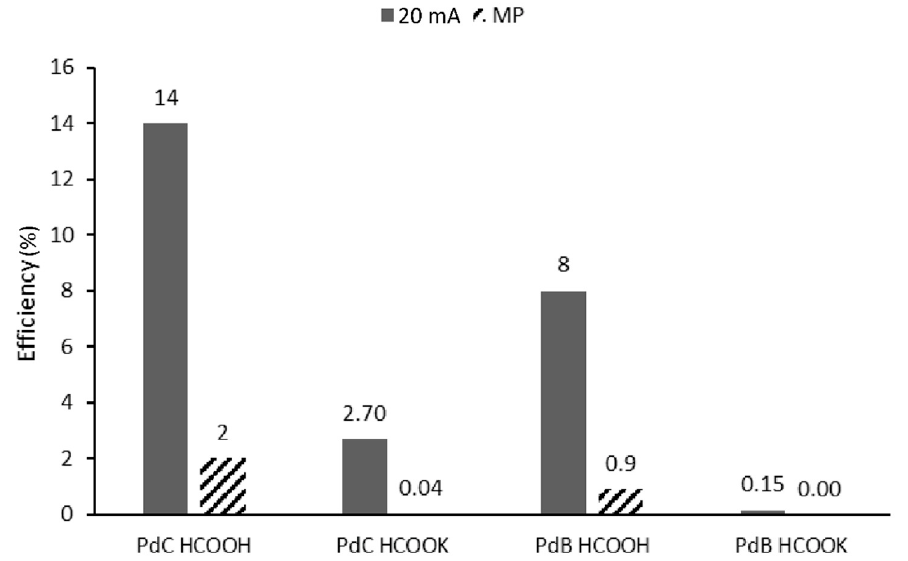
Figure 7. Constant current discharging efficiency at 20 mA and maximum power current (MP).